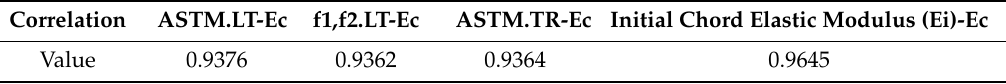
Table 5. Comparison of errors and correlations between Ei and dynamic elastic moduli ( Eds ). Type of Errors ASTM.LT